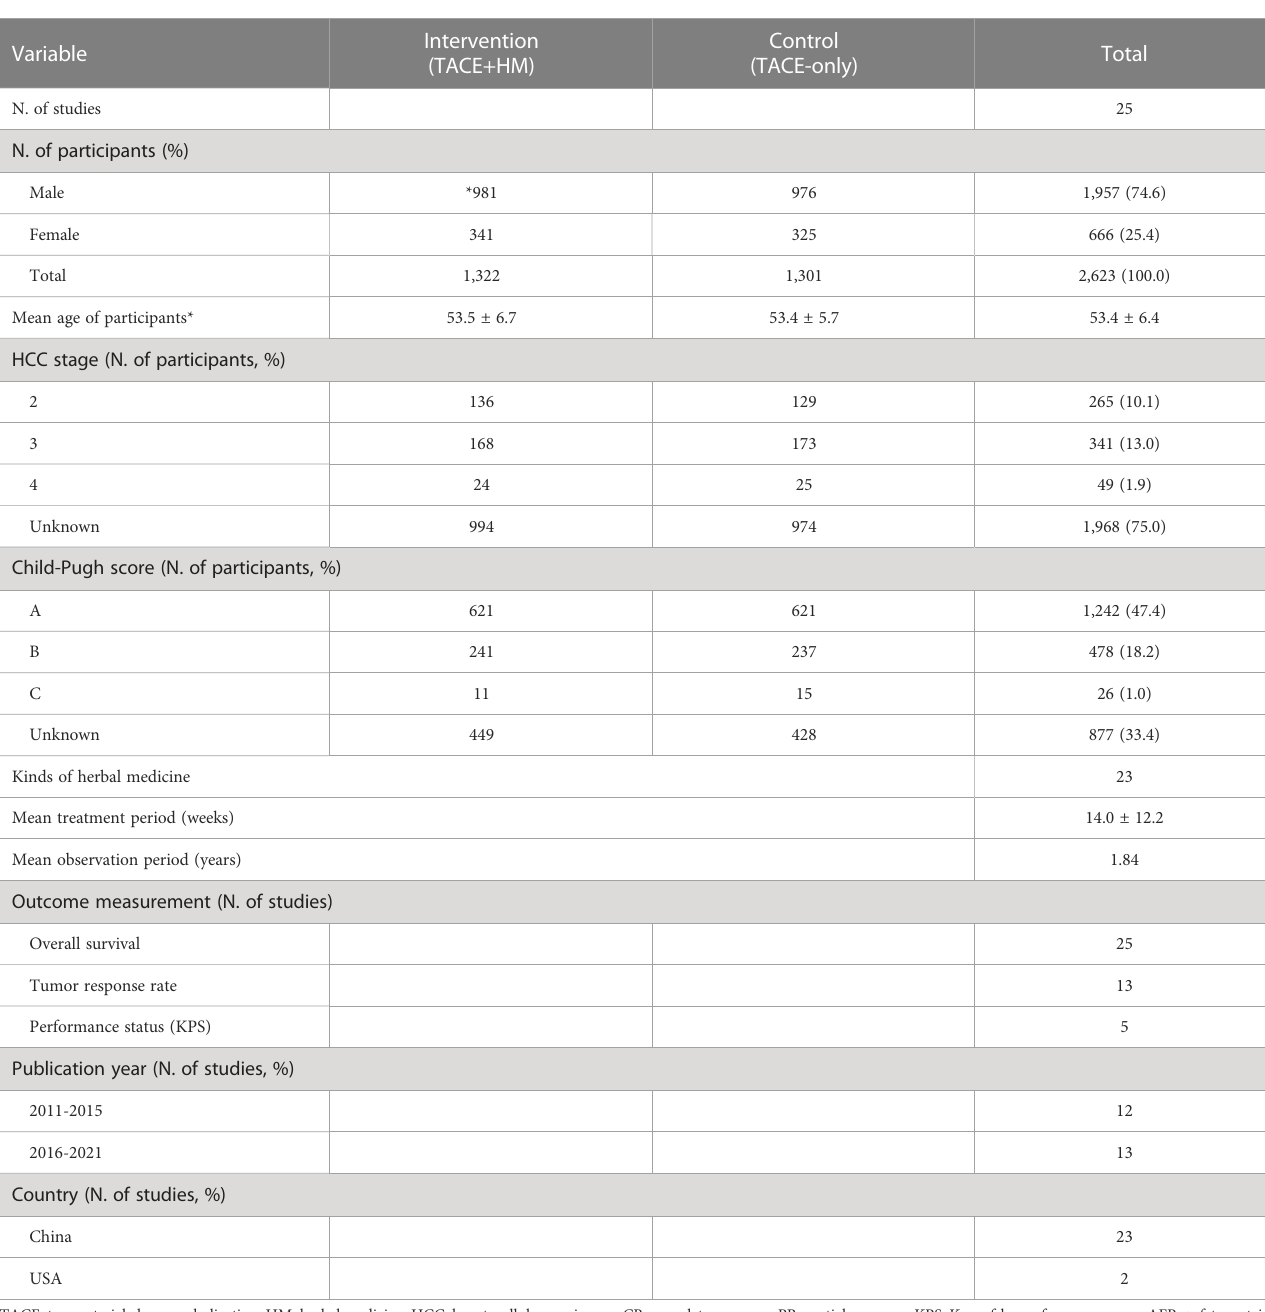
TABLE 1 Basic characteristics of the included